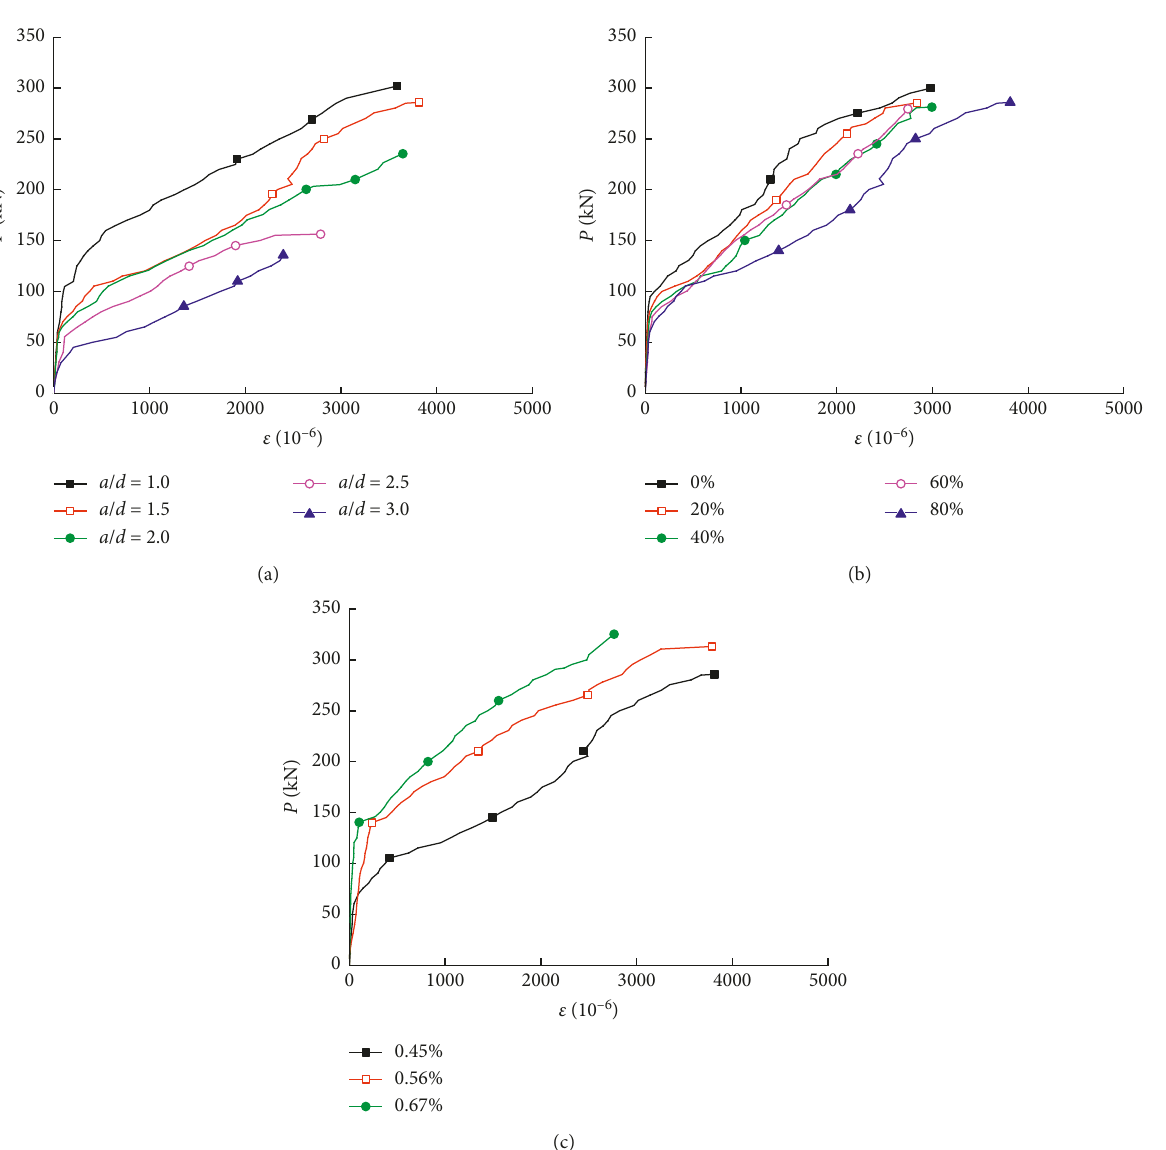
Figure 6: Load stirrup strain curves of beams: (a) series B1; (b) series B2; (c) series